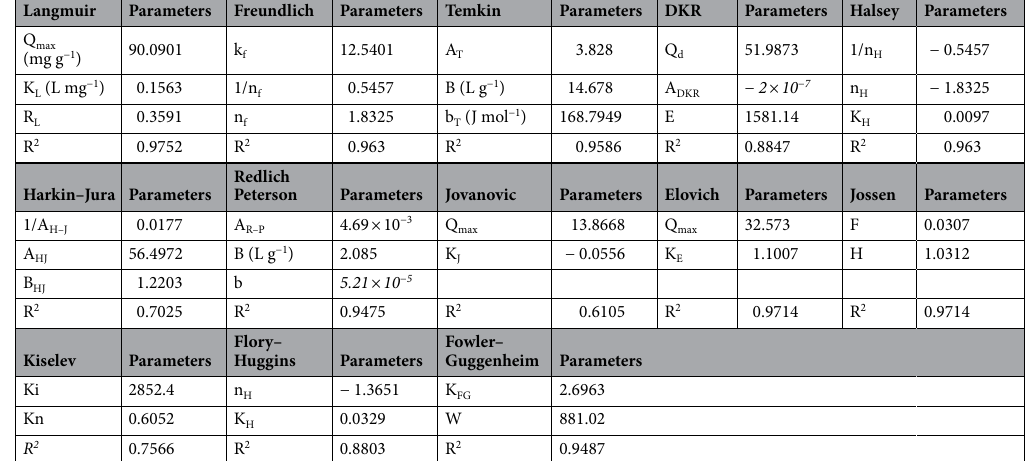
Table 3. Isotherm models and their various evaluated parameters for the adsorption of Cu 2+ onto nZVI.